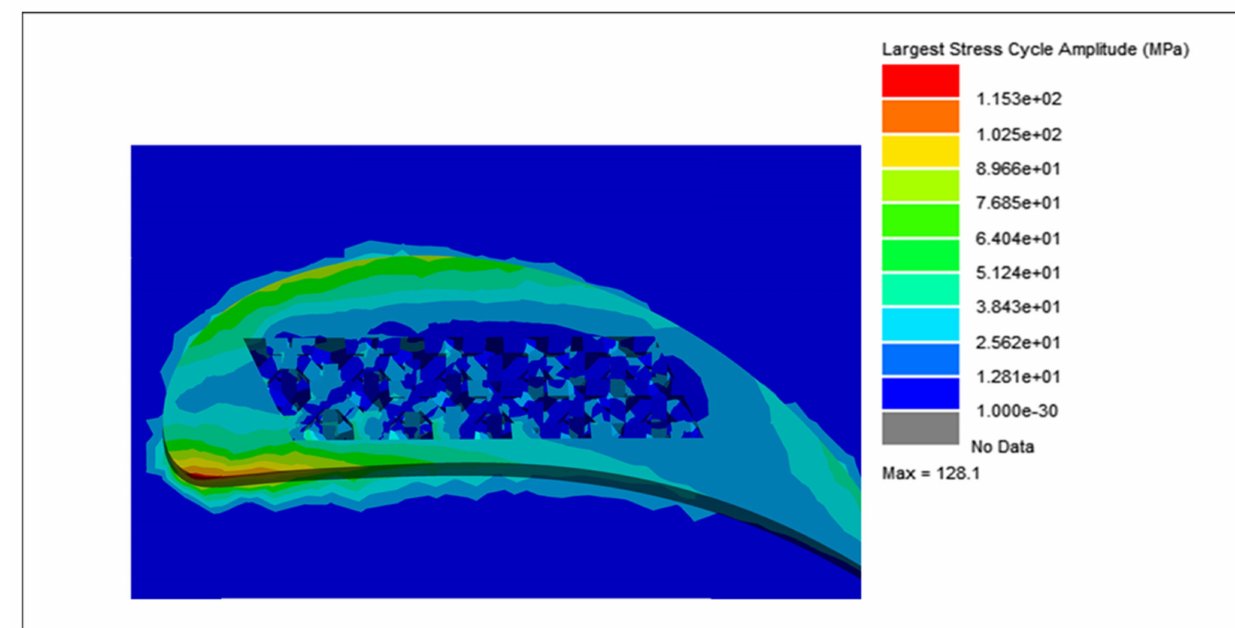
Figure 18. Largest stress cycle amplitude for the solid blade.